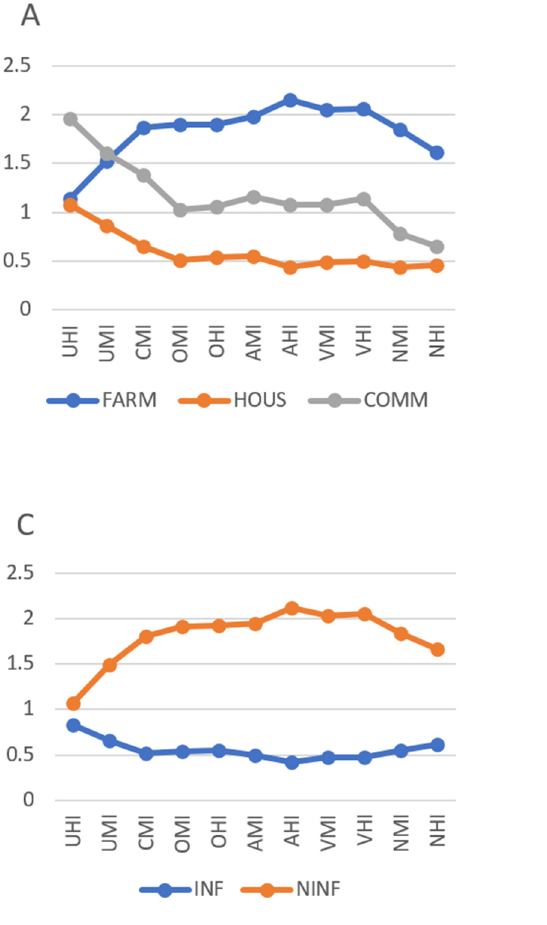
Figure 7. Ratios between suitability indices and their baselines calculated for the different scenarios and for each landscape class (descriptions of landscape classes’ codes are reported in Table 1, scenario codes in Table 2). ( A , B ): economic perspective, ( C , D ): infrastructure perspective. ( A , C ): supply-based suitability, ( B , D ): demand-based suitability.